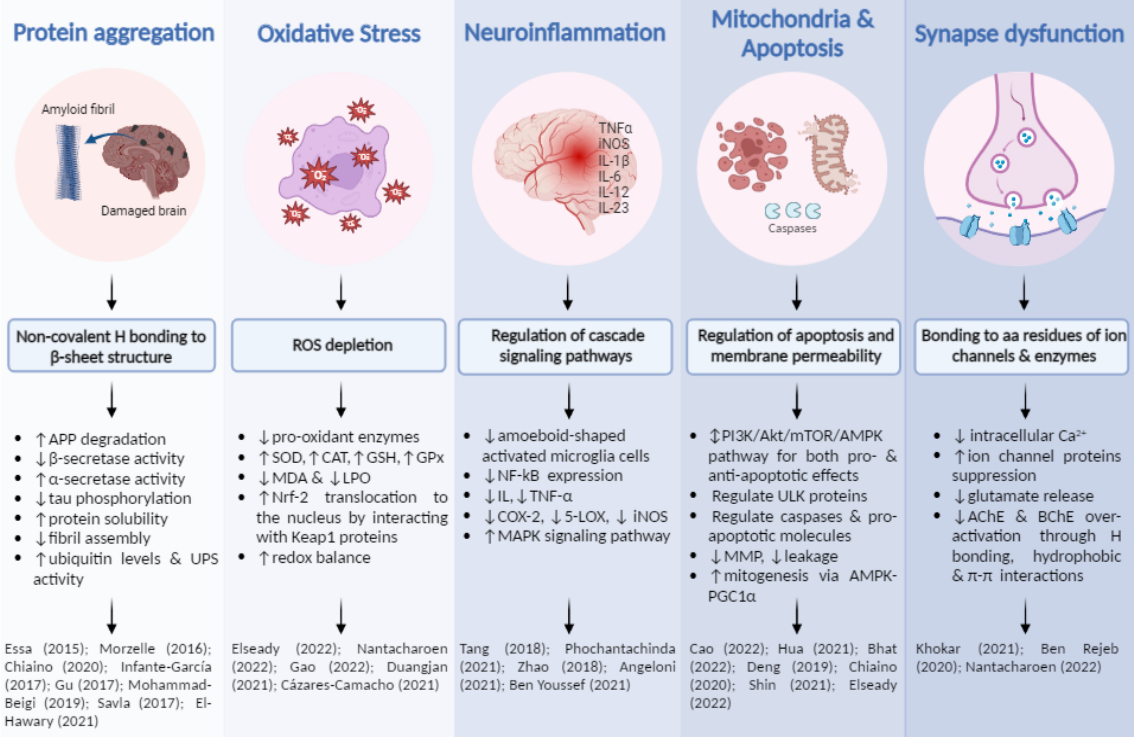
Figure 4. Main mechanisms through which plant extracts and their phenolic compounds exert their neuroprotective effects, as well as key cell processes involved. Finally, several references in which this information is demonstrated 89,92,93,95,102,108,110,115,123,130,131].